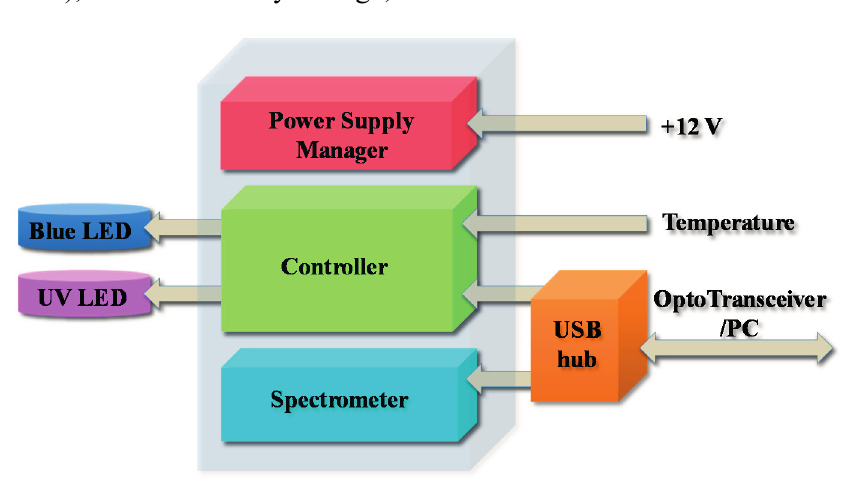
Figure 5. Electronic layout of the